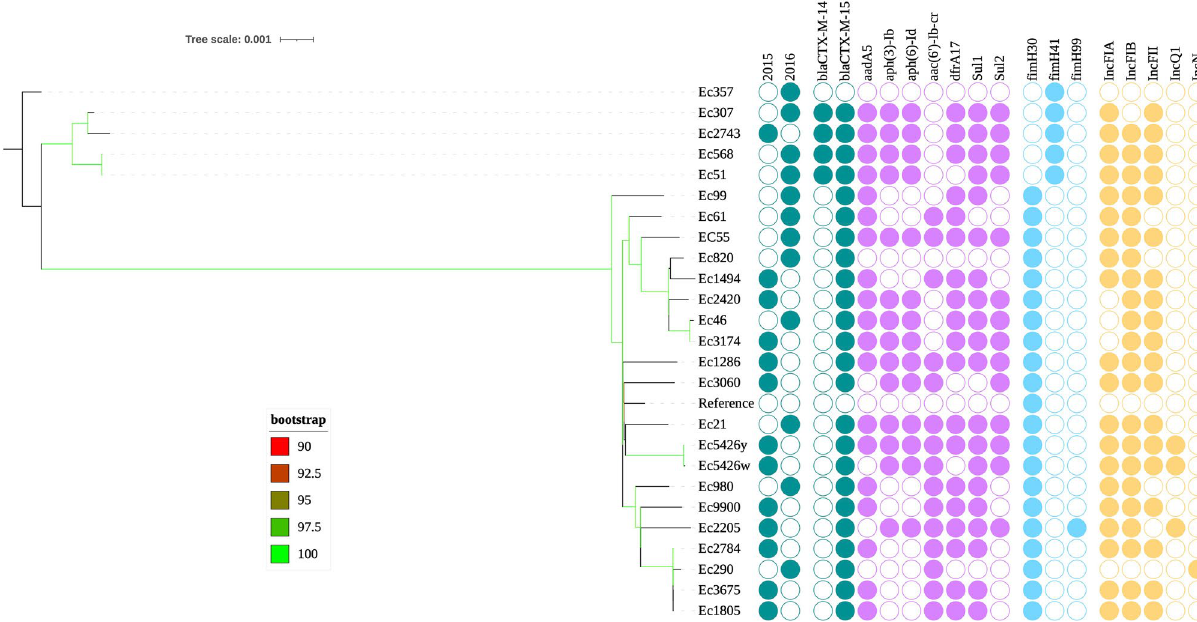
Figure 3. Rooted maximum-likelihood phylogenetic tree of 25 Escherichia coli ST131 isolates constructed based on 1037 core-genome alignment. Branch patterns were assessed by 1000 bootstrap replicates. Bootstrap support values are shown from 90 (minimum) to 100 (maximum). Year of isolation, presence of resistance genes, fim types, and plasmid replicon types are shown in a binary fashion as shaded circles with labels at the tips. Figure was visualized and annotated with ITOL v5 (https:// itol. embl. de/ perso nal_ page.